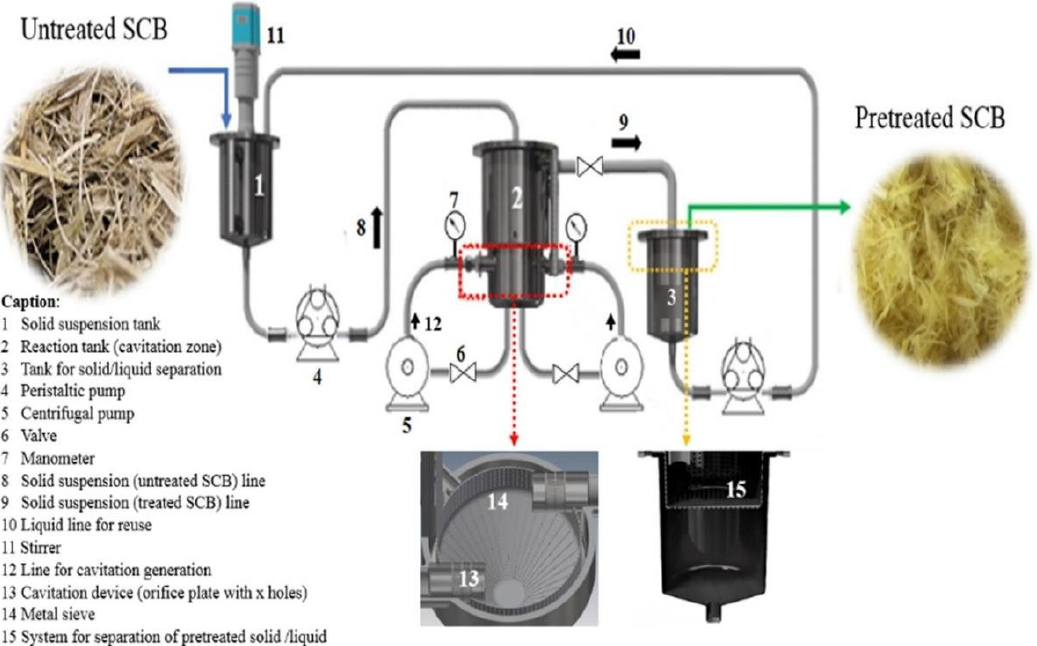
Figure 16. HC devices exploited for semi-continuous pretreatment of sugarcane bagasse. Reprinted from Bioresource Technology , 2019, 290, 121,777 with permission from Elsevier.